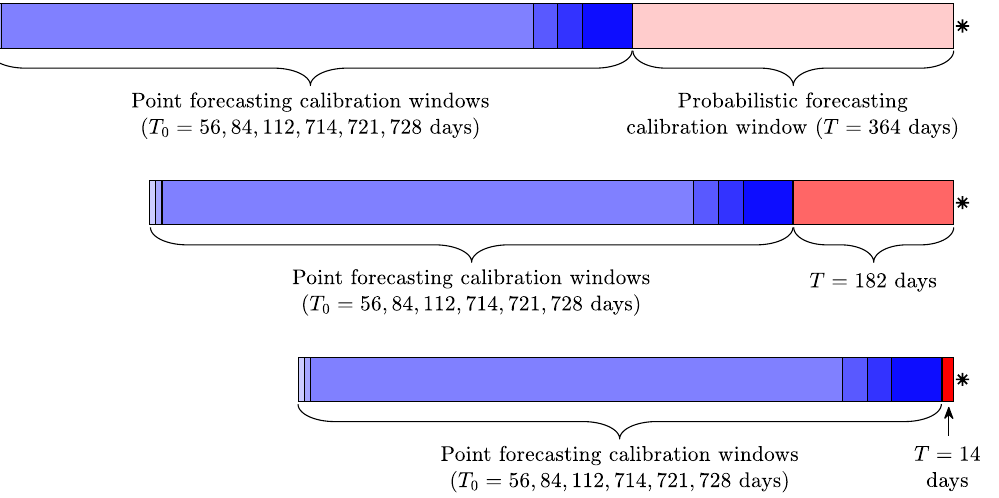
Figure 3. Illustration of our forecasting scheme. The target day for which the predictive distributions are computed is denoted by an asterisk ‘ ∗ ’. The calibration windows for probabilistic forecasts (red shaded bars; the darker the shade the shorter the window) end on the previous day. Here three windows are plotted: the longest considered ( T = 364 days; top ), an intermediate ( T = 182 days; middle ) and the shortest considered ( T = 14 days; bottom ). They are directly preceded by six calibration windows for point forecasts (blue shaded bars; the darker the shade the shorter the window) of T 0 = 56,84,112,714,721 and 728